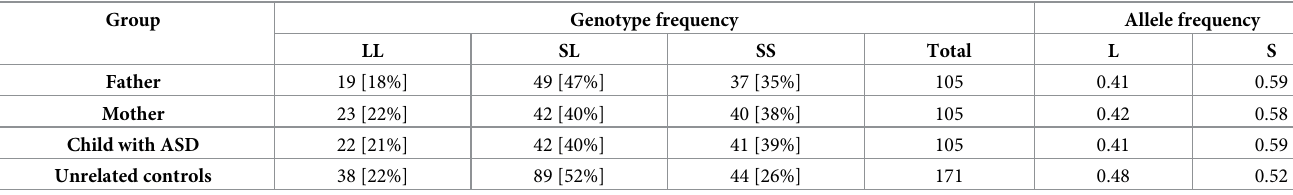
Table 1. 5-HTTLPR polymorphism in Colombian